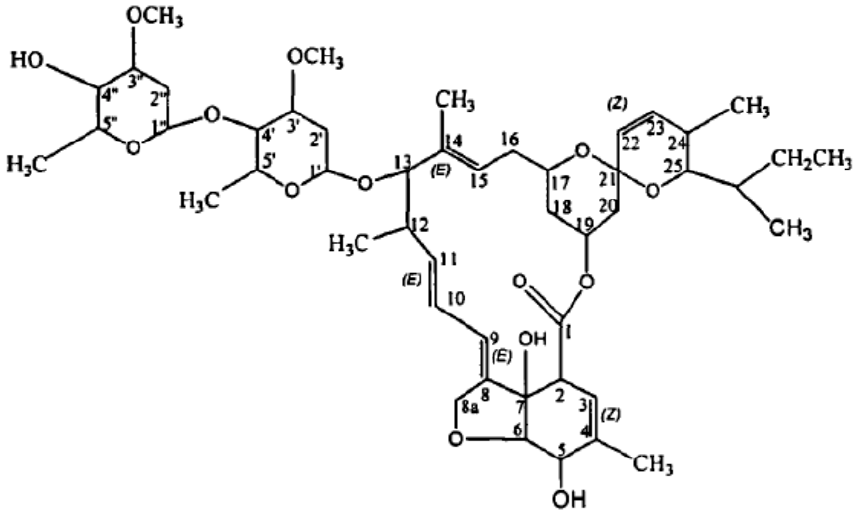
Figure 1. Molecular structure of abamectin.